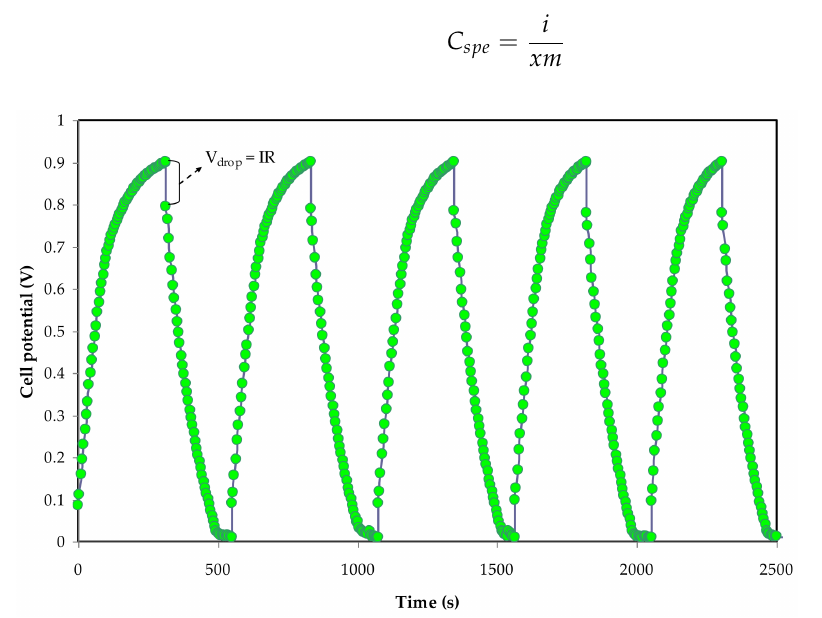
Figure 8. Galvanostatic charge–discharge curve for the constructed EDLC. The applied current is shown here as i . The slope of the discharge curve is (x). The C spe is plotted against the cycle number in Figure 9. The capacitance charge achieved in this system is moderately superior to that found in earlier studies. The first cycle’s calculated C spe value is 235 F/g, and the second cycle’s C spe value is roughly 60 F/g.